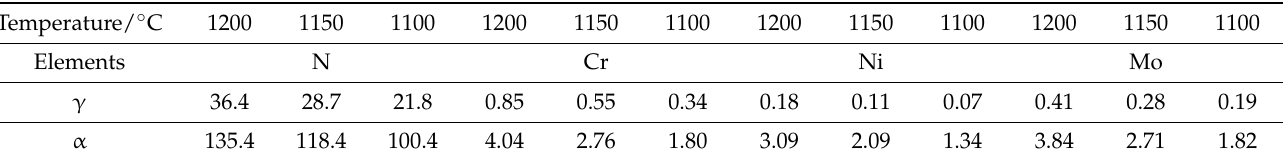
Table 6. Diffusion distance of elements during water cooling from 1200 ◦ C, 1150 ◦ C and 1100 ◦ C ( µ